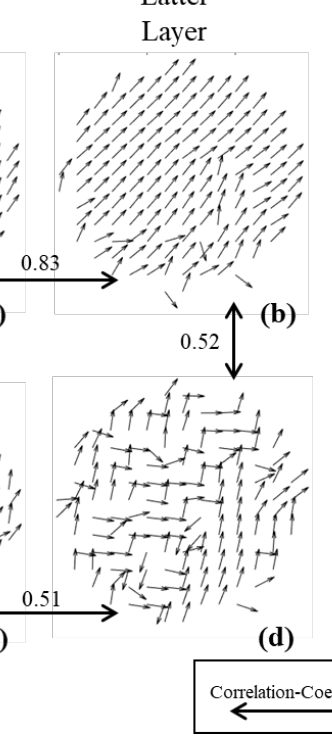
Figure 8. Fast axis orientation flow diagram of two-layered simulation. ( a ) initial image of former layer; ( b ) initial image of latter layer; ( c ) after loading image of former layer; ( d ) after loading image of latter layer.